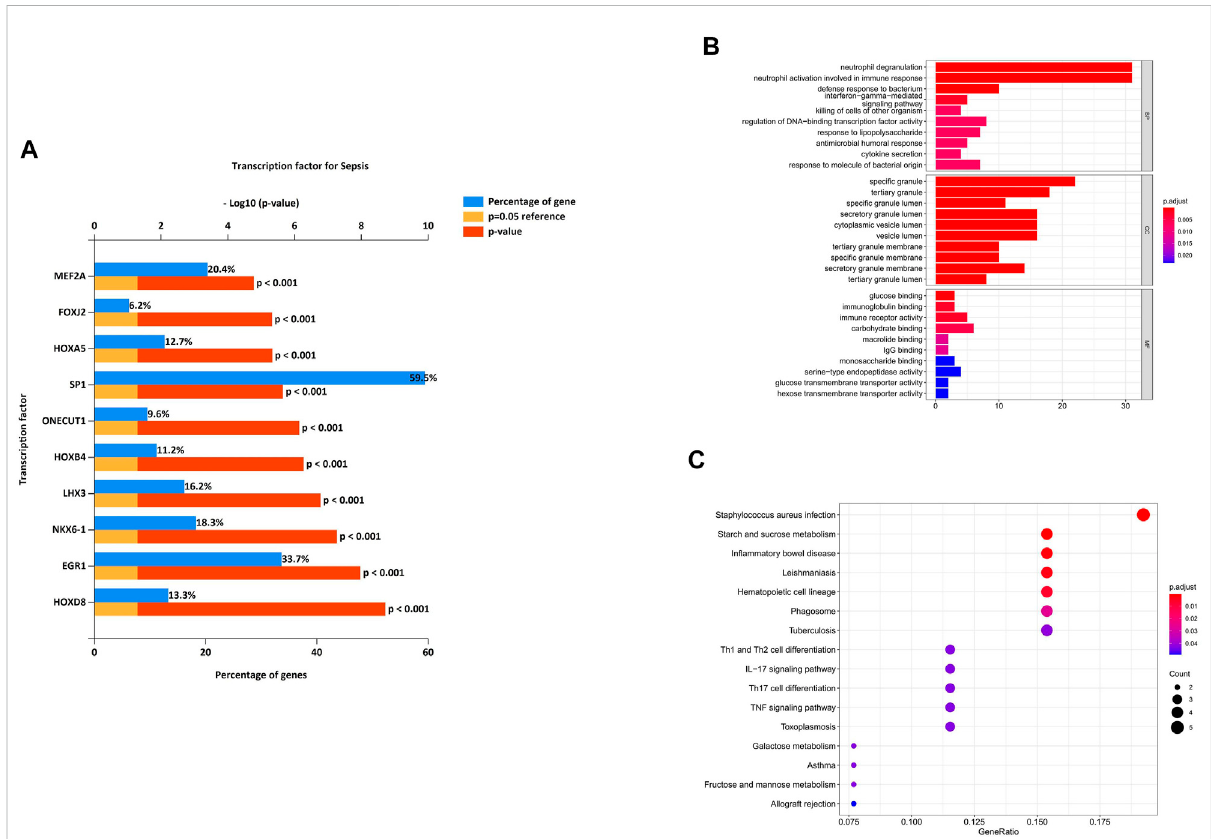
Characteristicsandfunctionalanalysisofdifferentiallyexpressedgenes(DEGs). (A) Differentiallyexpressedtranscriptionfactorsassociatedwith the identi fi ed DEmiRNAs. HOXD8, EGR1, NKX6-1, LHX3, HOXB4, ONECUT1, SP1, HOXA5, FOXJ2 and MEF2A were the most signi fi cant molecules